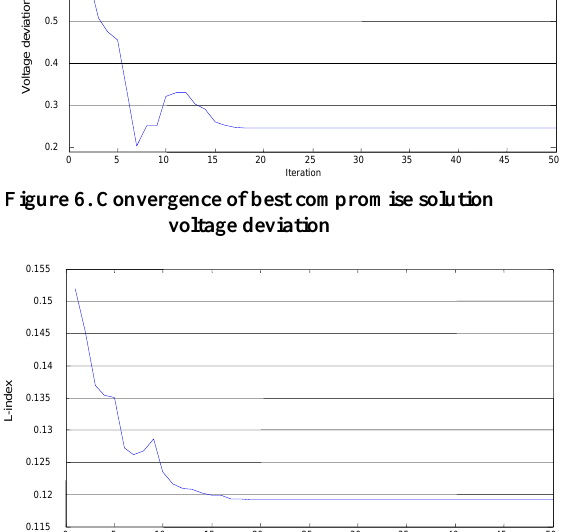
Figure 7. Convergence of best compromise solution